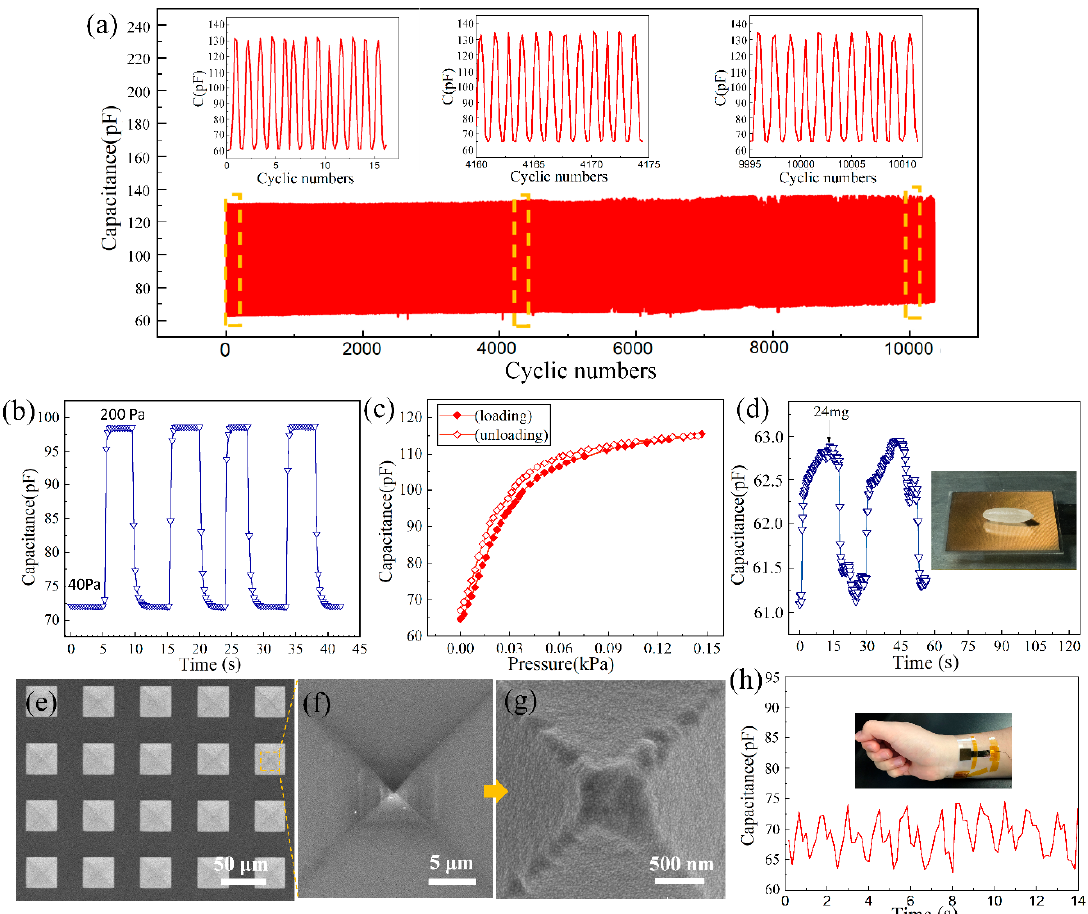
Figure 7. ( a ) Durability test under the pressure of 0–300 Pa, ( b ) stability and ( c ) hysteresis test of the sensor, ( d ) transient response to the application and removal of a 24-mg-weight rice seed on the sensor, the corresponding pressure is 1 Pa, ( e ) SEM image of the pyramid microstructures after pressure tests, indicating the robustness of the metal coating under pressure. ( f ) and ( g ) are the detailed image of the Ti/Au-coated PDMS tip after pressure tests, the square stains are generated under different pressures, ( h ) real-time detection of the wrist pulse signal.